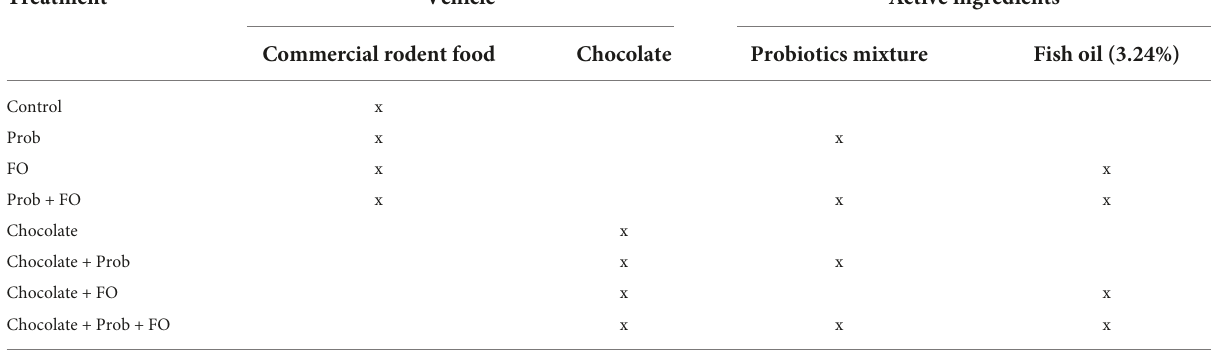
TABLE 1 Treatments composition of rat diets. Treatment